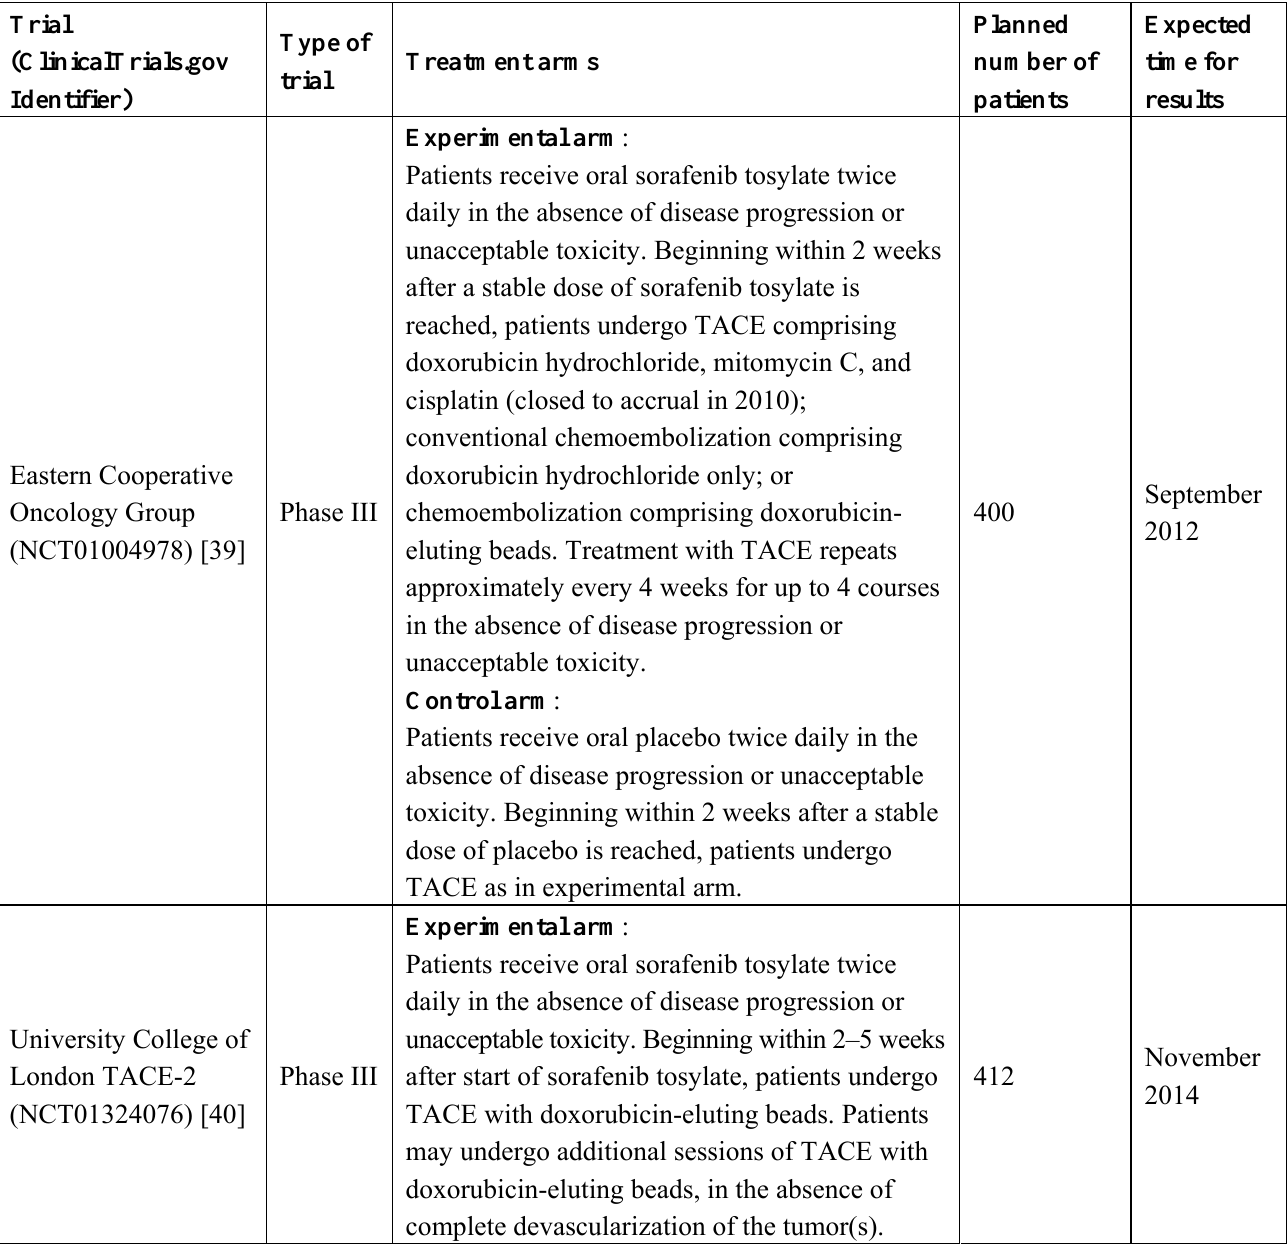
Table 1. Ongoing randomized trials testing the addition of sorafenib to trans-arterial chemoembolization for patients with intermediate stage hepatocellular carcinoma. Trial